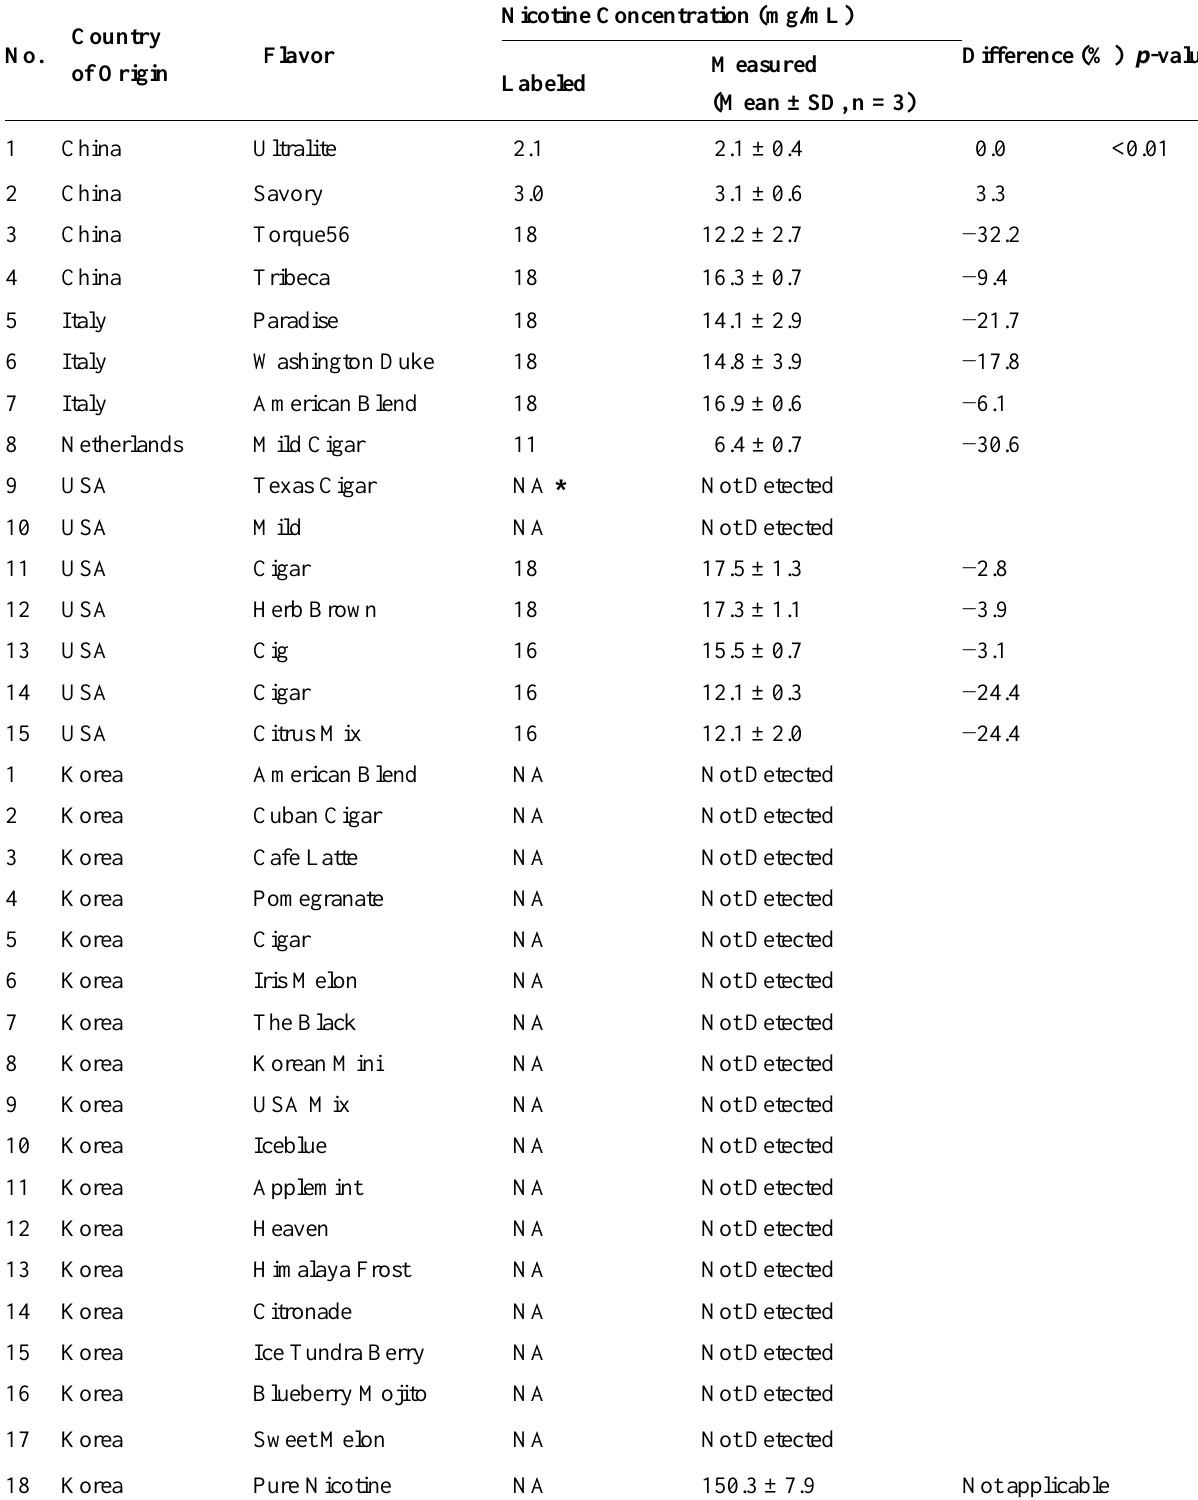
Table 2. Comparison of labeled and measured nicotine concentration